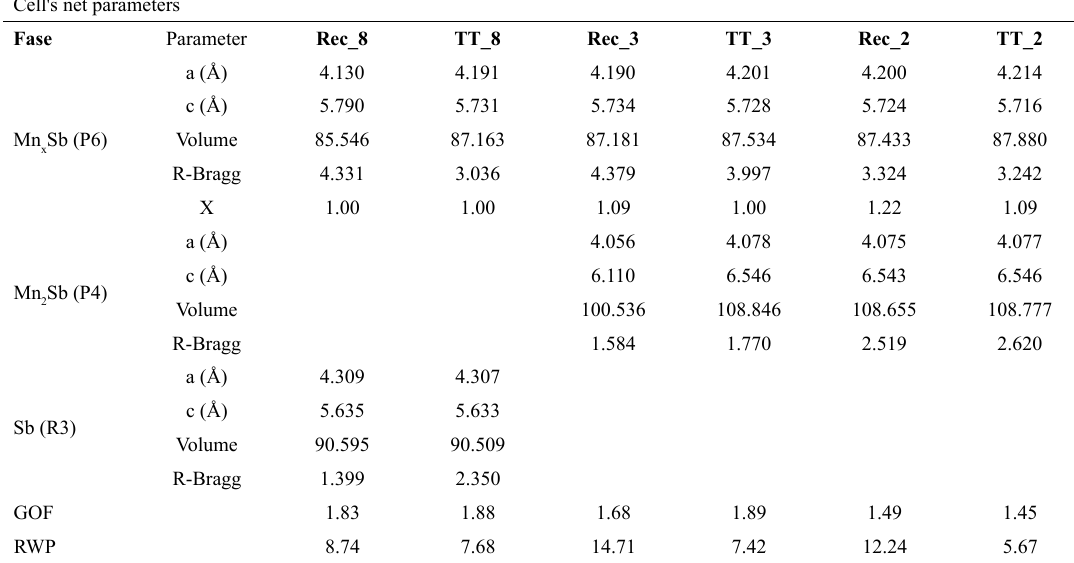
Table 3. cell's lattice parameters Cell's net